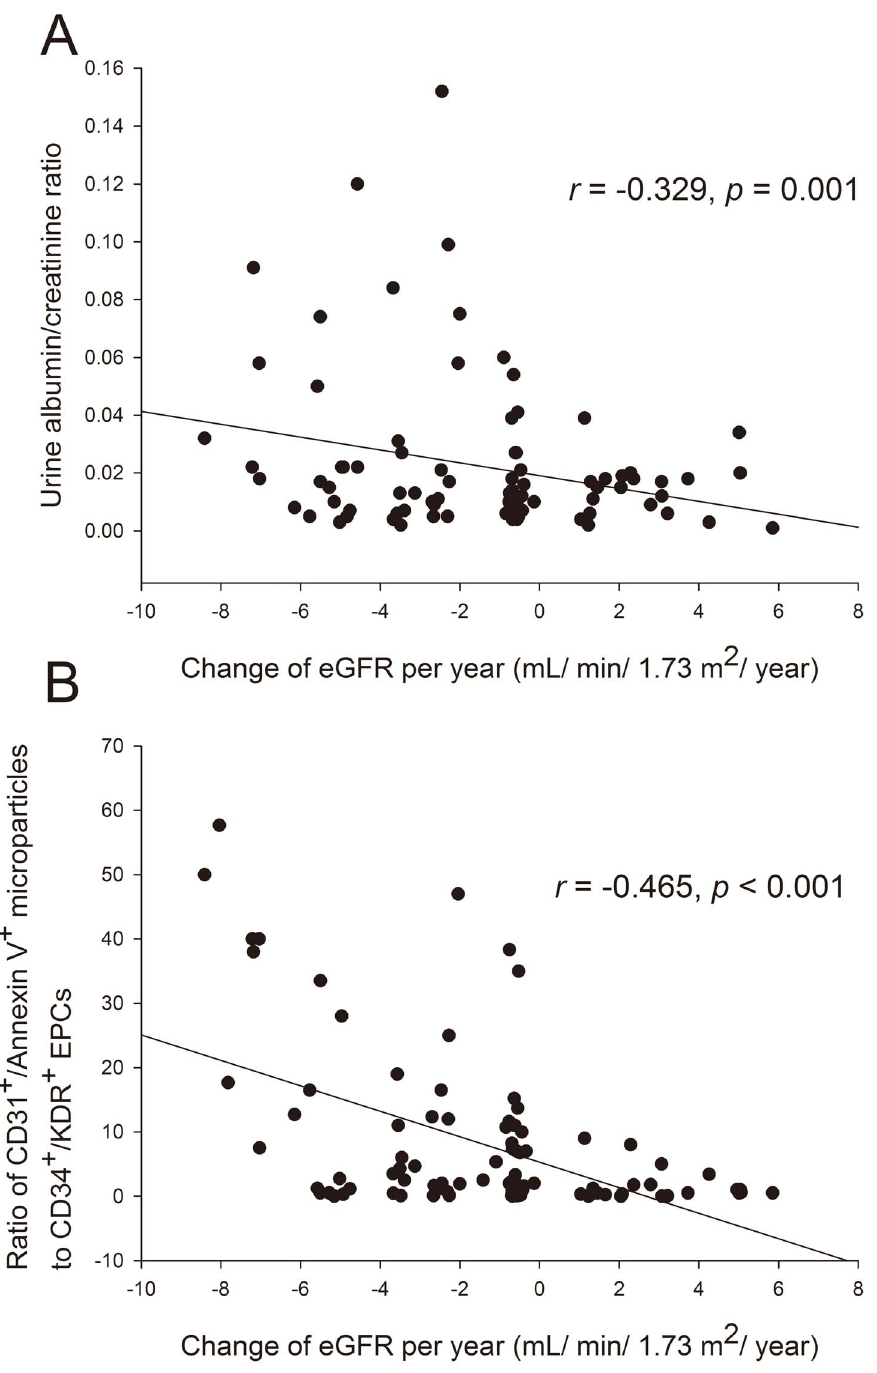
Figure 3. The association between microalbuminuria, EMP/EPC ratio, and eGFR decline rate. The distribution and association between: (A) the microalbuminuria (urine albumin/creatinine ratio) and annual change of estimated glomerular filtration rate (eGFR); and (B) the ratio of CD31 + /Annexin V + microparticles to CD34 + KDR + CD133 + endothelial progenitor cells (EPCs) and annual change of eGFR in 100 hypertensive patients.